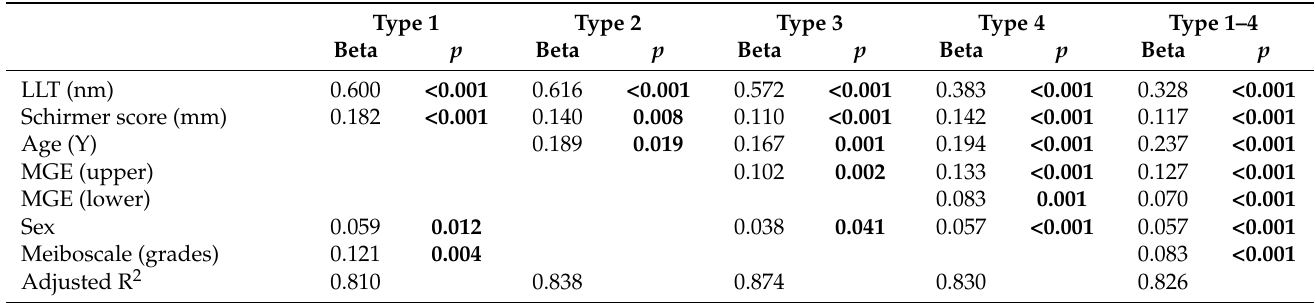
Table 7. Summary of stepwise multiple linear regression models for